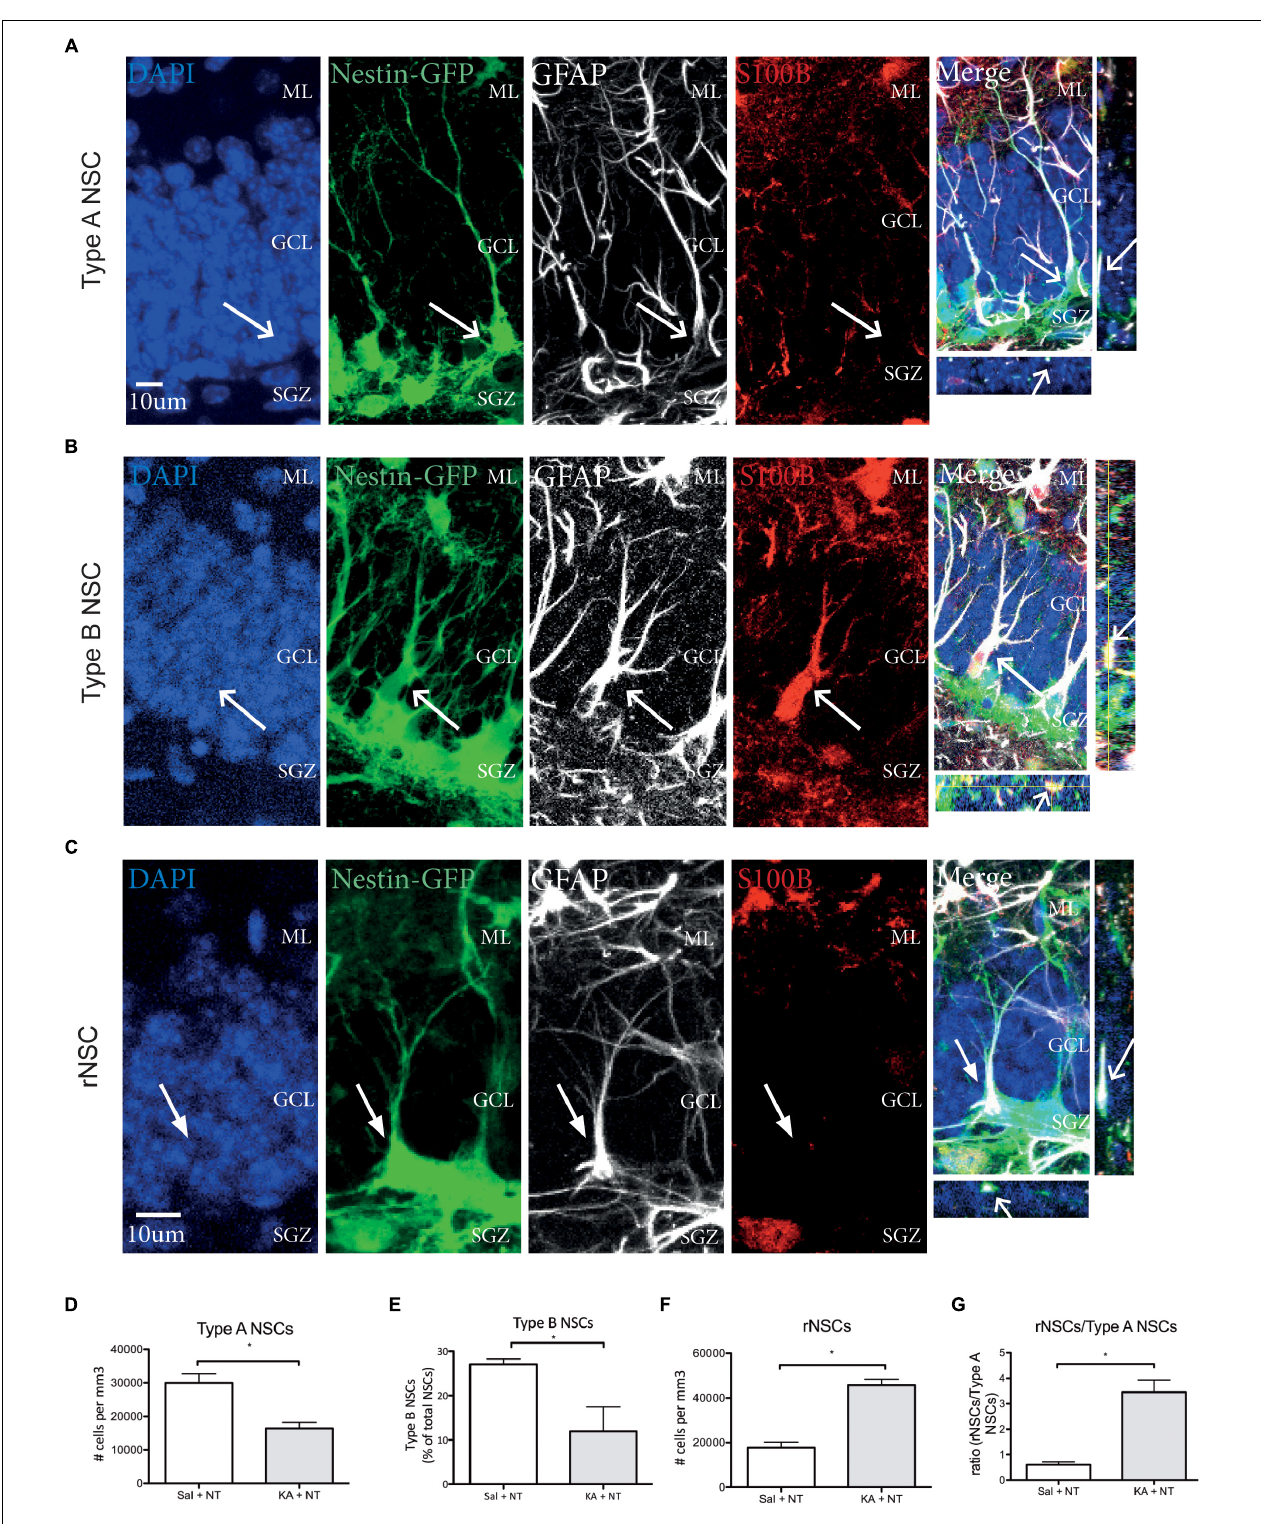
FIGURE 4 | Effects of non-convulsive seizures on NSC identity. Example confocal images of (A) Type A NSCs (B) Type B NSCs (C) reactive NSCs, as assessed by marker expression and morphology. (D) Upon induction of ncSZ a significant loss of Type A NSCs was found. (E) At the same time, the relative proportion of Type B NSCs in the NSC pool also decreases upon induction of ncSZ. (F) Simultaneously, a significant increase in the number of rNSCs occurs, an effect that becomes even more visible when comparing the rNSC/Type A NSC ratio (G) . ∗ P < 0.05.